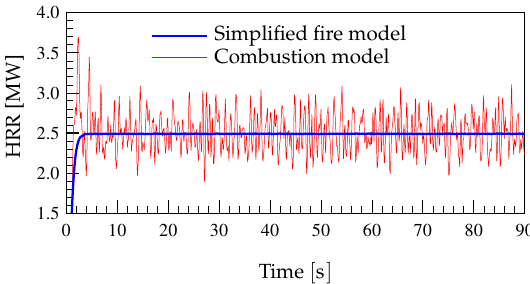
Figure 7. Heat release rate (HRR) in the simulations of cases G-1 to G-4 (Table 1), compared with that of the EDC combustion model.